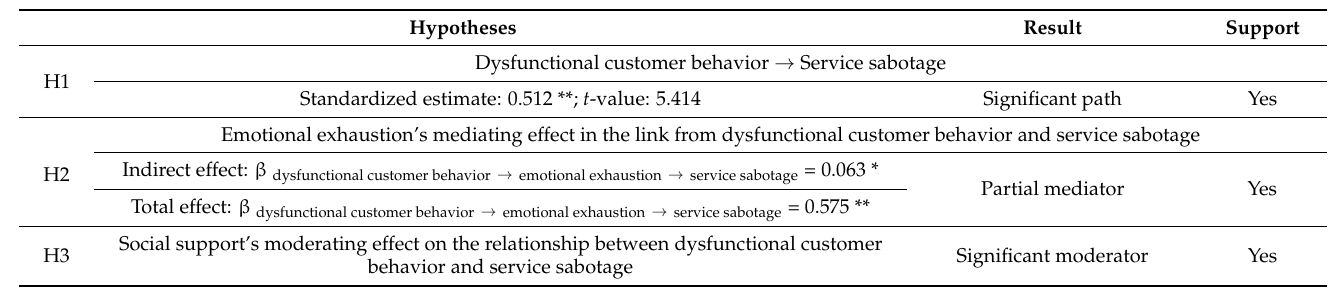
Table 5. Hypotheses test